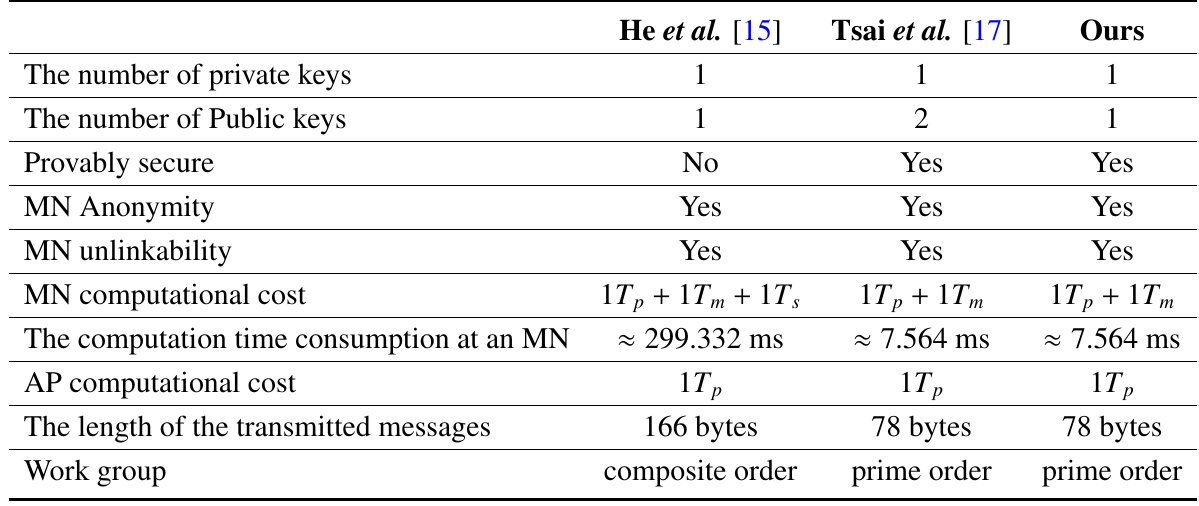
Table 1. Protocol comparisons. MN, mobile node; AP, access